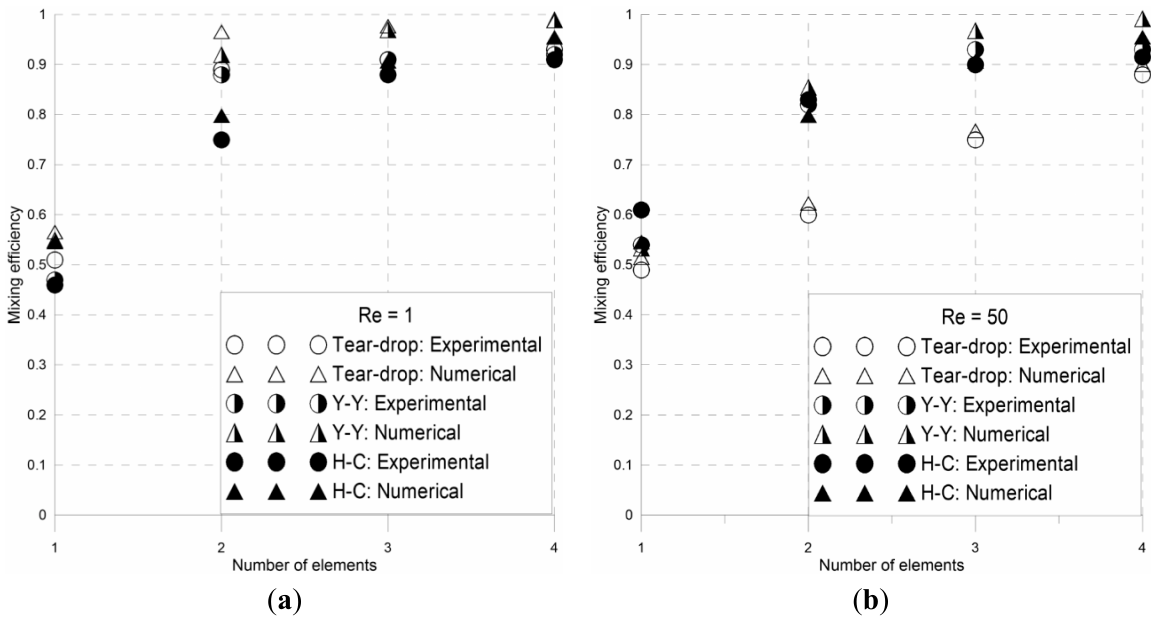
Figure 9. Experimental and numerical mixing efficiency of the Tear-drop, the Y-Y, and the H-C micromixers, varying their number of elements: ( a ) Re = 1; ( b ) Re = 50.